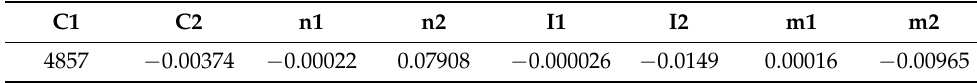
Table 7. Constant of the C60 grade steel material